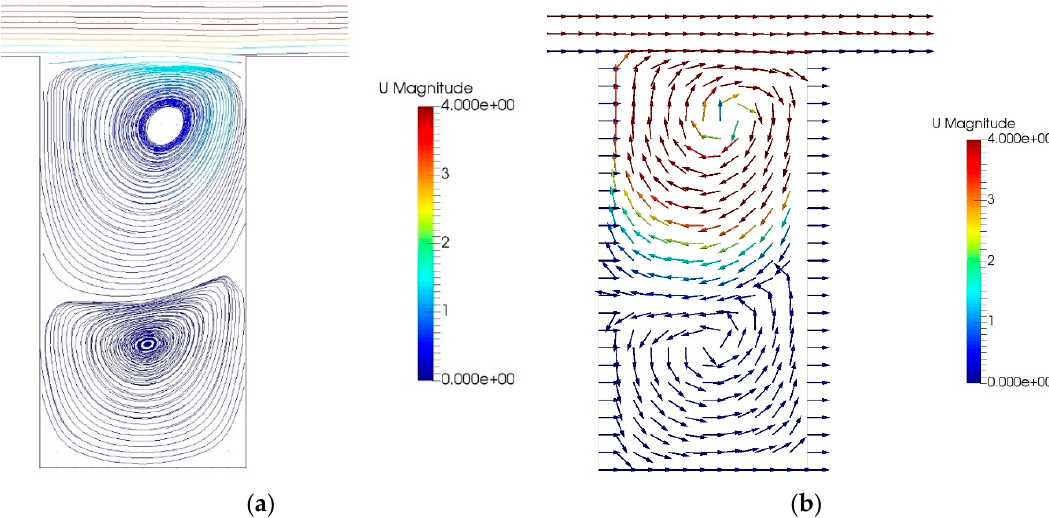
Figure 5. Streamlines ( a ) and velocity vector ( b ) (1) of wind flow inside the street canyons with aspect ratio (AR) = 2. ( (1) Due to the velocity inside the canyons being too small in comparison with the ambient velocity, the magnitude of the velocity vector presented in the graphs (from now on in the manuscript) is scaled by the color bar rather than by the length of the vector).